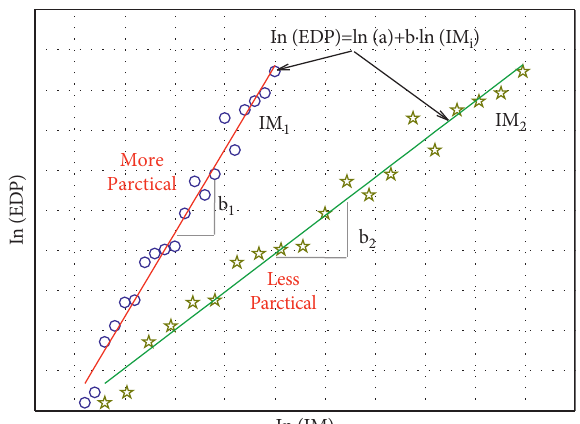
Figure 5: Example of the relative practicality of intensity